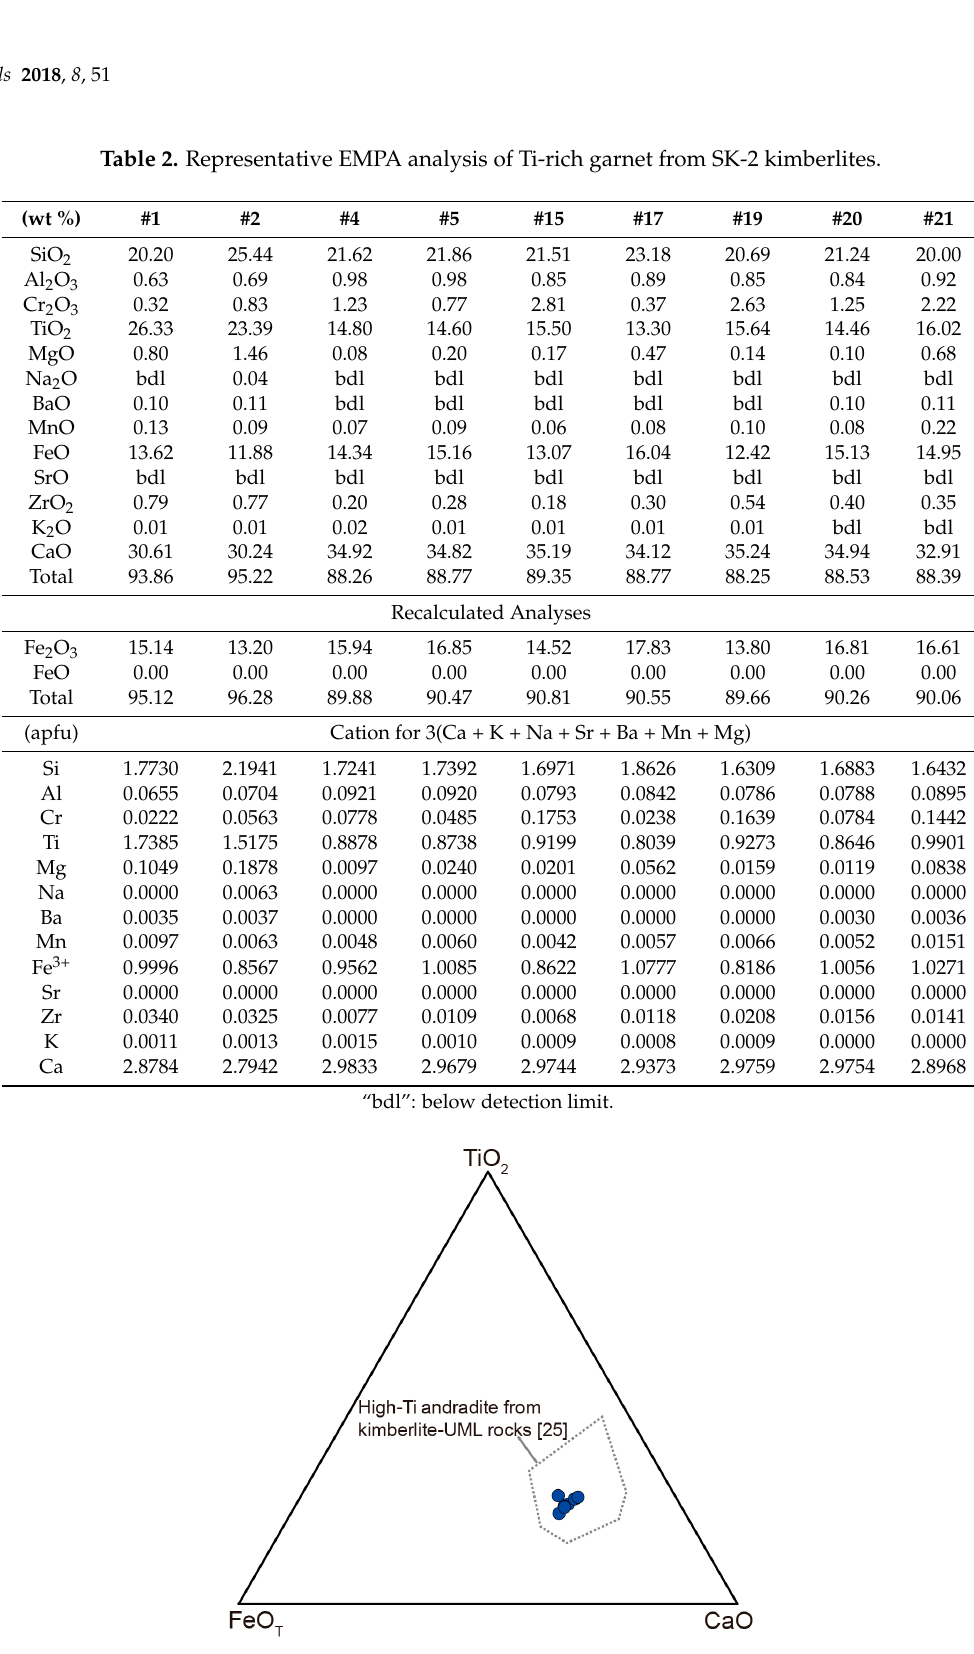
Figure 6. Compositional variation of TiO 2 , FeO T and CaO for Ti-rich garnet from SK-2 kimberlite pipe compared with Ti-rich andradites from ultramafic lamprophyres [25].